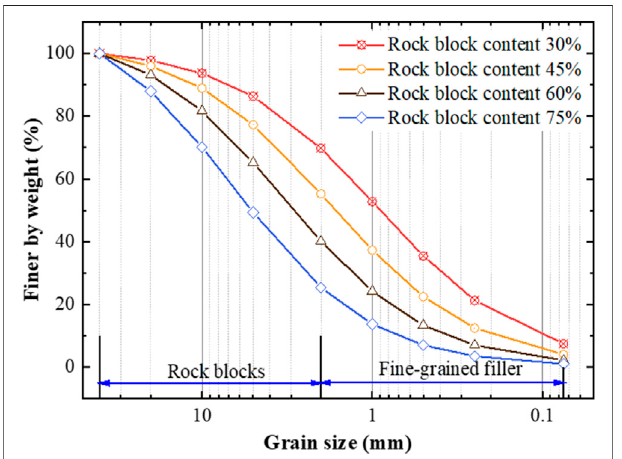
FIGURE2| Compactioncurvesoffourdesignedgradedcoarse-grained fi